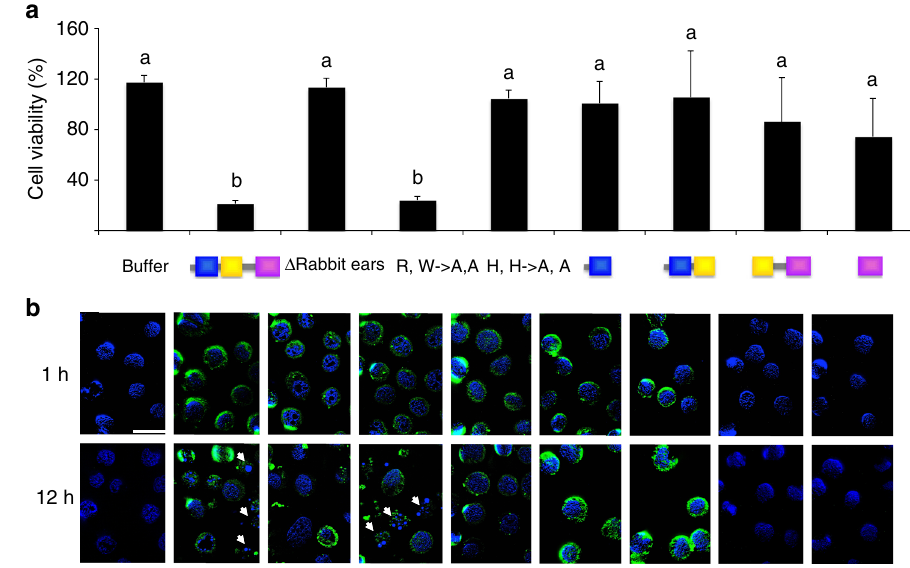
Fig. 5 Functional role of nigritoxin domains. a Cytotoxic activity of wild type (domains schematically represented in blue: N-terminal; yellow: central; magenta: C-terminal), truncated forms, and mutants ( Δ rabbit ears: deletion of the protruding loops; R,W- > A,A: Arg512 and Trp540 replaced by two Ala; H, H- > A, A: His598 and His650 replaced by two Ala) of nigritoxin on insect cells. Sf9 cells were incubated with 1.2 μ M of truncated forms or mutants of nigritoxin or with the same volume of protein suspension buffer for 12 h. The cytotoxicity was monitored using Alamar Blue assay. For each condition, the cell viability was compared to mock (untreated) cells set at 100% viability and expressed in percentage ( y -axis). The experiment was performed twice in triplicate and data are presented as mean ± S.D. Means with the same letter are not signi fi cantly different from each other (Kruskal – Wallis, p < 0.05). b Cellular localization of wild type, truncated, and mutant versions of nigritoxin in Sf9 cells. Cells were incubated with puri fi ed proteins/fragments (1.2 μ M) for 1 and 12 h, fi xed and detected by immunochemistry. Nuclei are stained in blue with DAPI. White arrows indicate nuclei damages. Scale bars: 20 μ